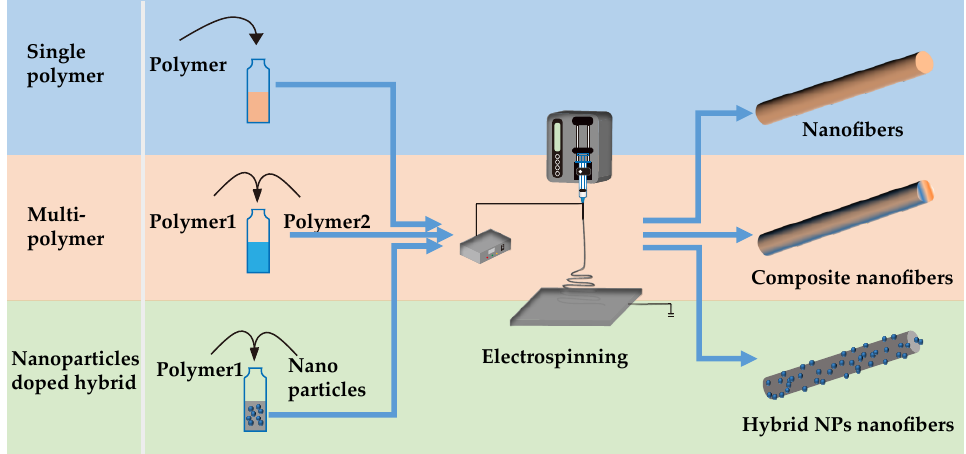
Figure 9. Comparison of preparation processes of single-polymer nanofibers, multiple-polymer composite nanofibers, and nanoparticle-doped hybrid nanofibers.